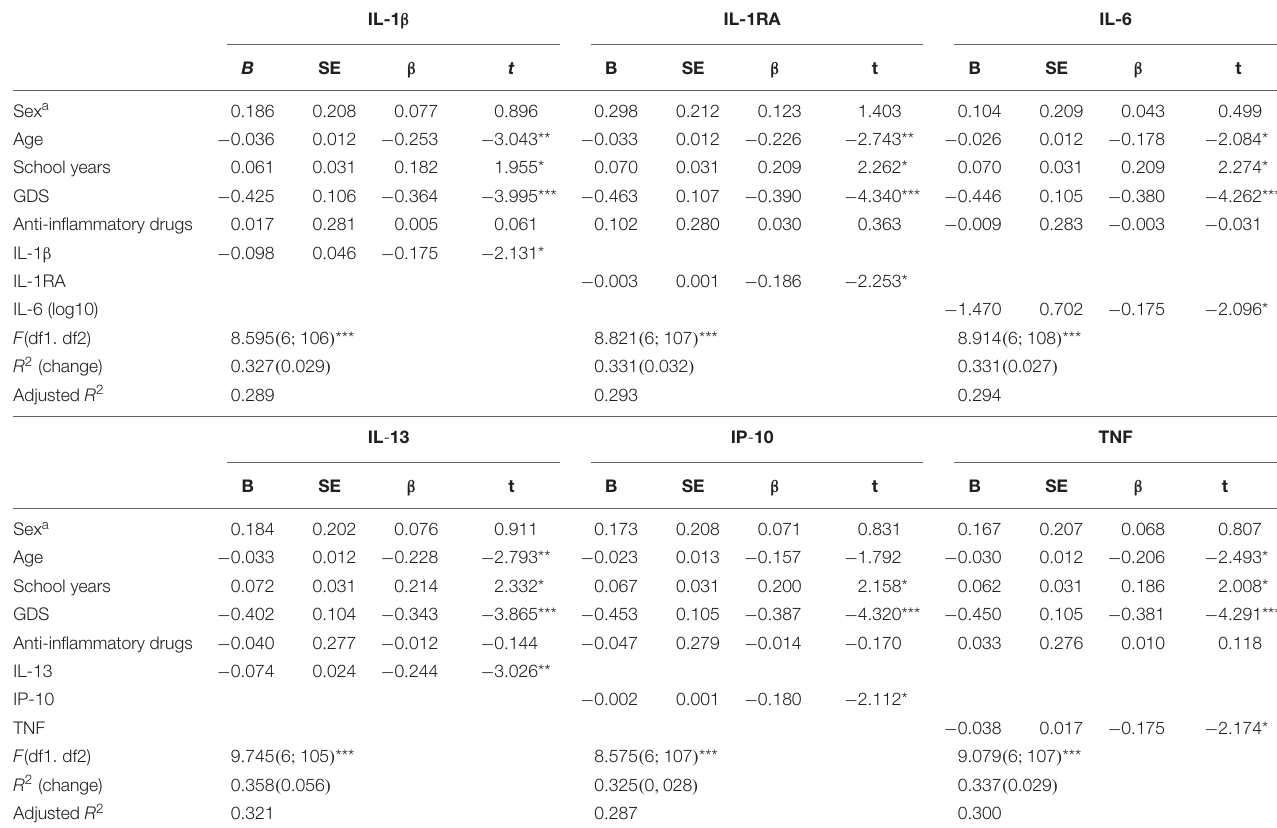
TABLE 3 | Linear regression models to explain the variance of memory